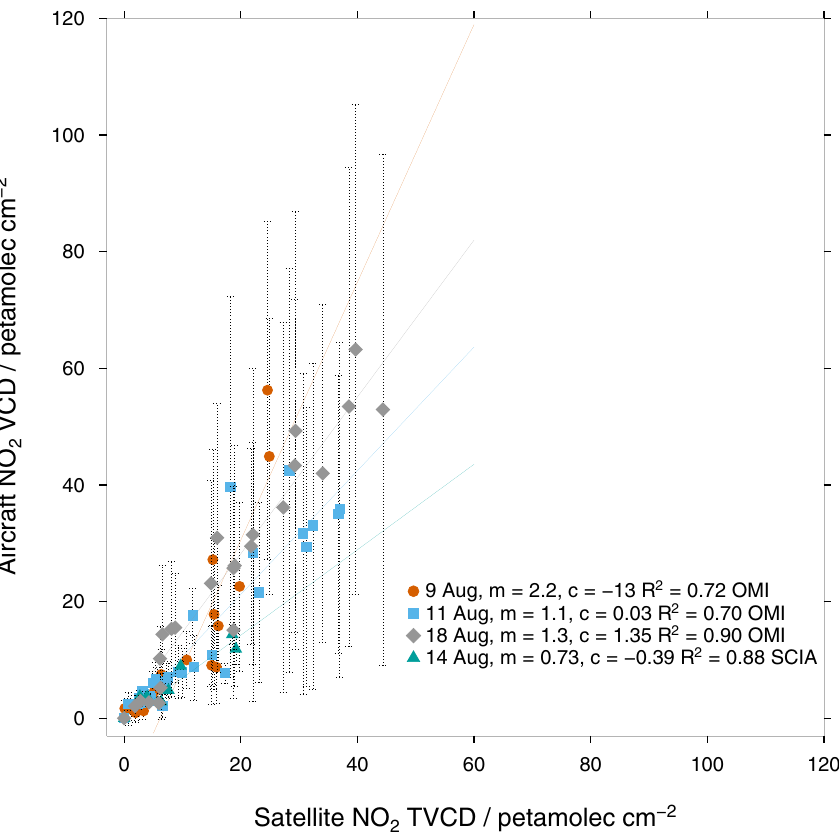
Figure 11. OMI and SCIAMACHY measurements compared with co-located line-averaged aircraft measurements. Aircraft iDOAS VCD is calculated using the mean of the minimum and maximum AMF calculated for the high-resolution measurement. Error bars indicate the minimum and maximum iDOAS VCD found within the satellite pixel. Regression lines are fitted through measurements greater than 5petamoleccm − 2 for each flight. The slope ( m ) of the regression line for each day is indicated, as well as the y intercept ( c ) and the regression coefficient ( R 2